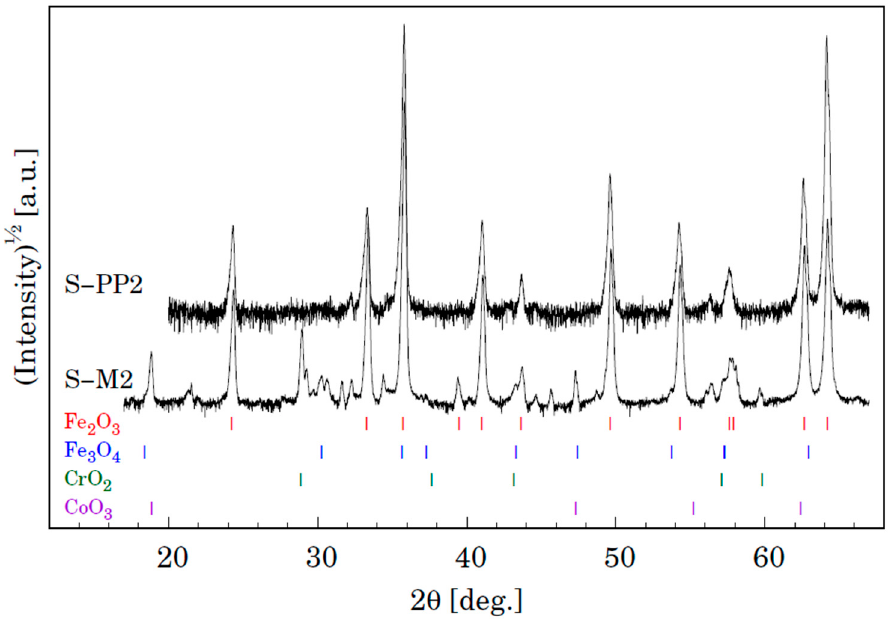
Figure 17. XRD patterns for samples S-P4 (P91) and S-7 (MarBN) oxidized for 3000 h at 650 °C. Vertical lines shown at the bottom depict positions of Bragg reflections belonging to Fe 2 O 3 and Fe 3 O 4.